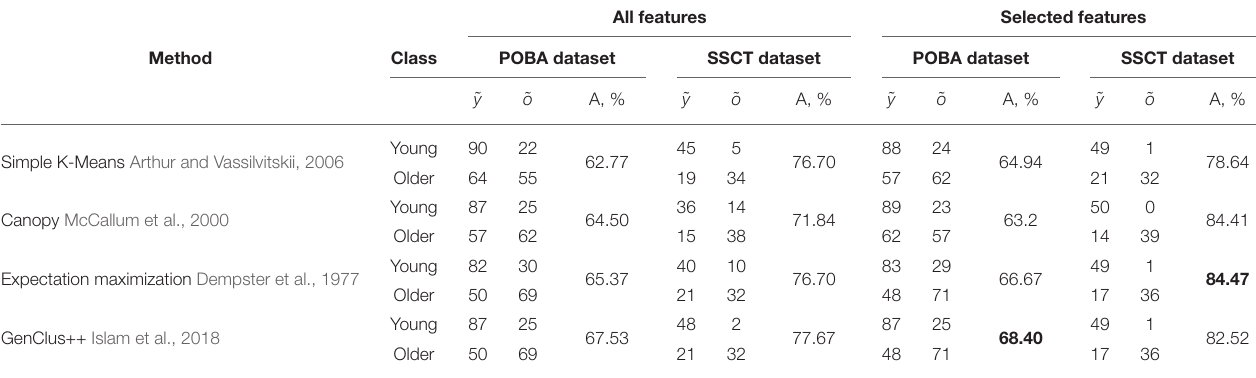
TABLE 6 | Performance of clustering machine learning methods for the psychophysiological outcomes of brain atrophy and Stroop switching card test datasets assessed using the confusion matrix and prediction accuracy.